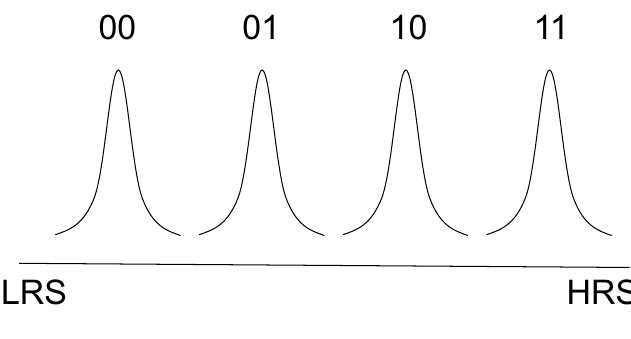
Figure 6. An MLC resistance distribution.